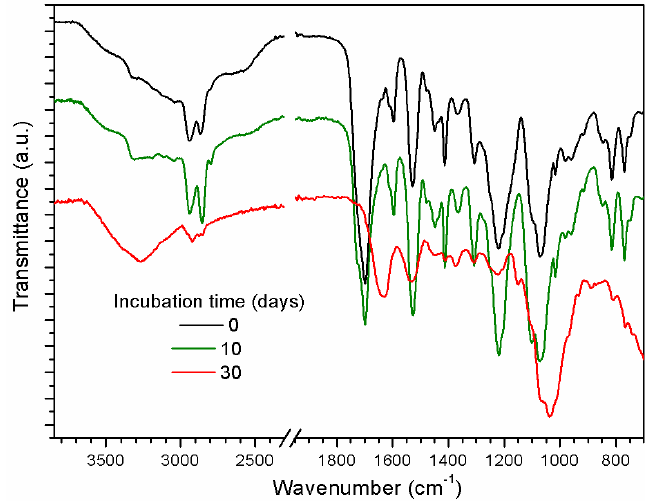
Figure 7. FTIR-ATR spectra of PU films treated with UV in the presence of AA vapors for 30 min without incubation and after incubation for 10 and 30 days. The spectra were slightly moved in the vertical direction for better presentation. For the assignments of the main bands refer to Figure 2.